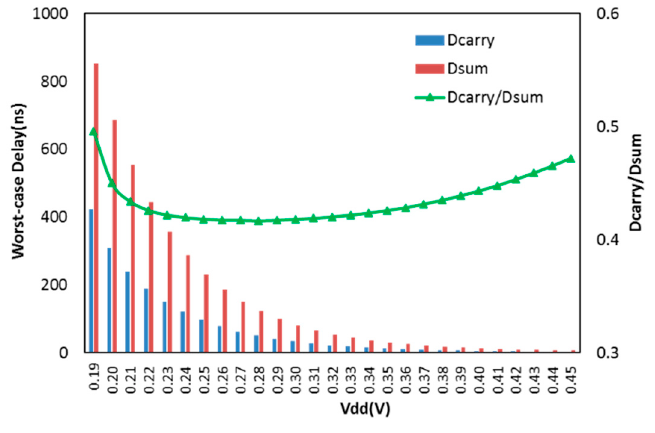
Figure 6. 𝐷 (cid:3030)(cid:3028)(cid:3045)(cid:3045)(cid:3052) and 𝐷 (cid:3046)(cid:3048)(cid:3040) versus 𝑉 (cid:3031)(cid:3031) . Figure 6. D carry and D sum versus V dd